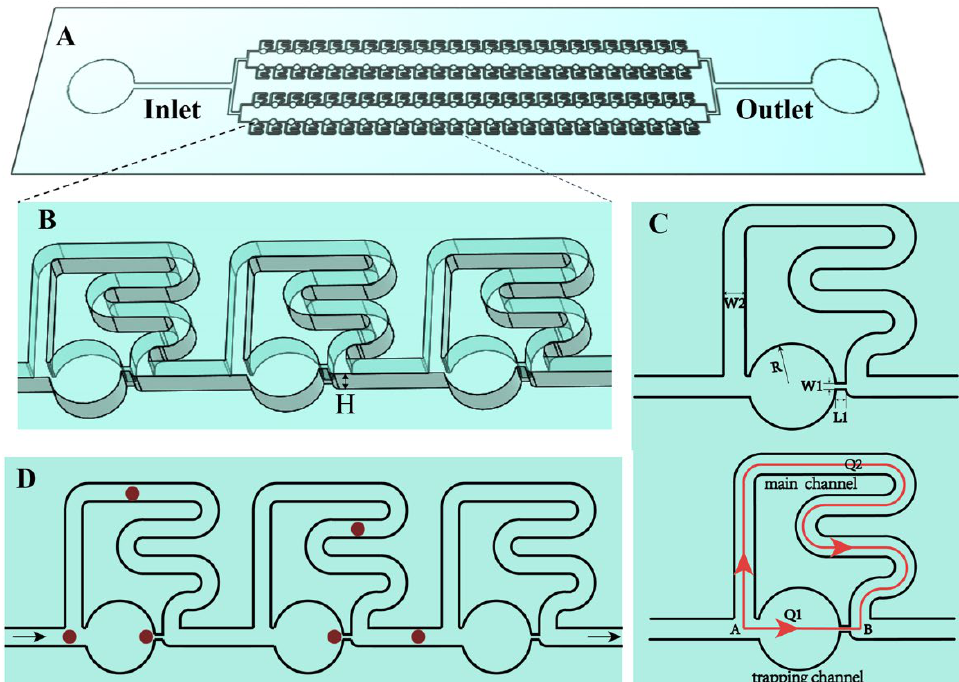
Figure 1. Microfluidic chip for single-cell trapping. ( A ) Schematic of the proposed single-cell trapping chip. ( B ) The detailed three-dimensional structure of proposed single-cell trapping chip. ( C ) The structure design of the single-cell trapping units. The geometric parameters W1, L1, R, W2 affecting the trapping efficiency were labeled. The design of a large circular structure before the constriction and the serpentine structure allowed the main channel to produce higher flow resistance than the trapping channel and cells would flow along the trapping channel. ( D ) Schematic of cell movement in the channels. When the capture site was taken by the cell, the next cell would flow around the trapping channels and flow along the main channels to the next capture site.